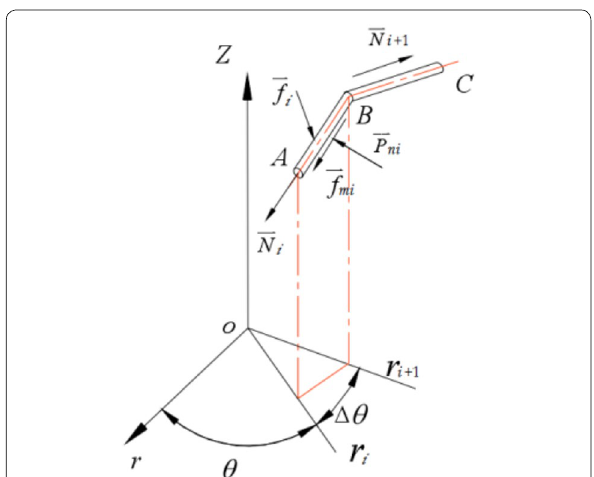
Figure 9 Force modeling of sectional divided wire rod